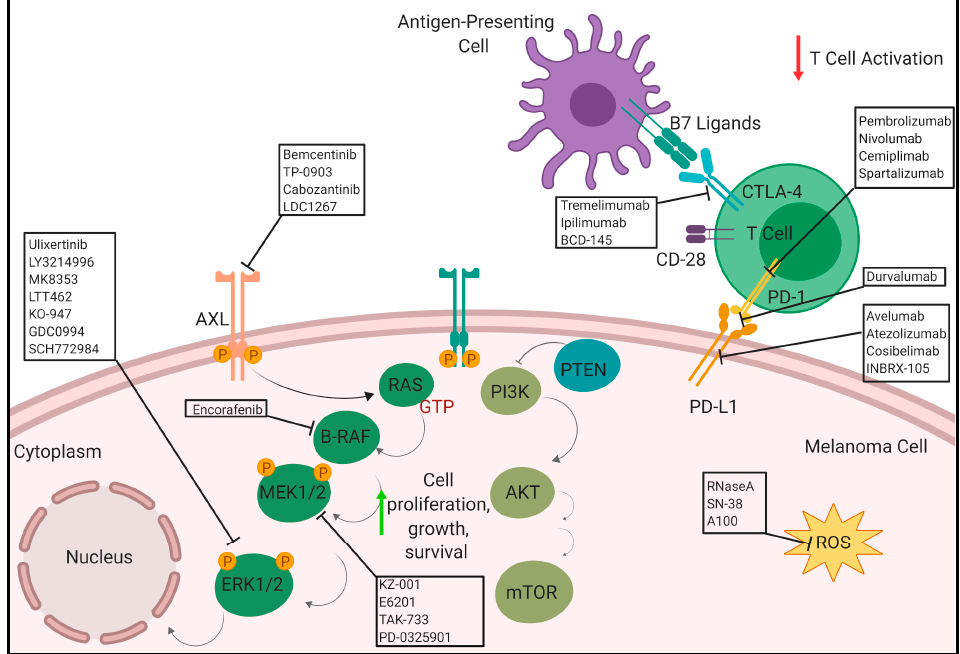
Figure 1. Novel therapies in pre-clinical and clinical phases (Anti PD-1/anti-PD-L1, anti CTLA-4, AXL inhibitors. BRAF inhibitors. ERK inhibitors and ROS activated prodrugs) to treat patients with metastatic melanoma (created with BioRender; www.biorender.com).